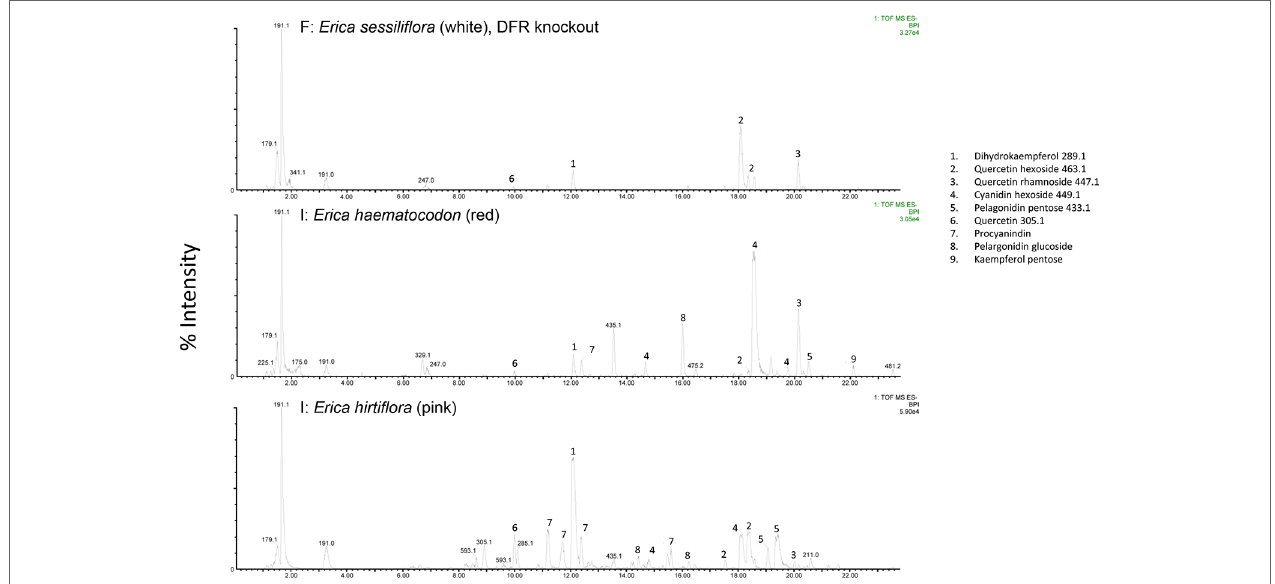
FIGURE 4 | UPLC-MS/MS results from white-, red- and pink flowered species. Anthocyanin biosynthesis pathway products and intermediates are indicated (1-9). Dihydroflavanol-4-reductase (DFR) was knocked out in the white flowered species.